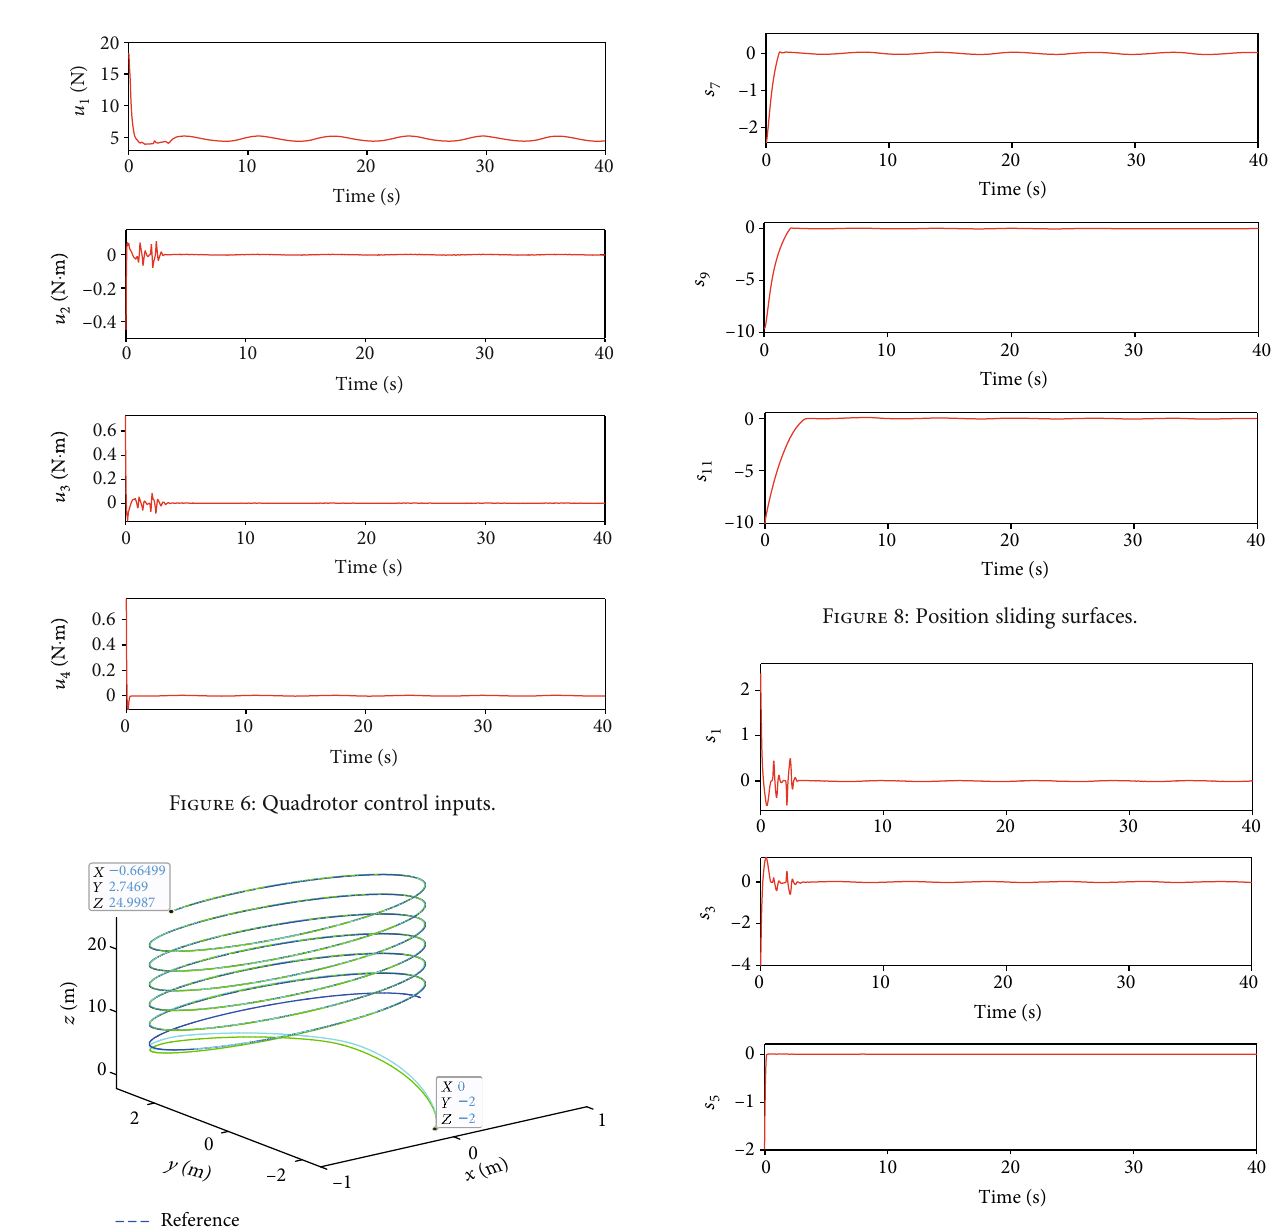
Figure 9: Attitude sliding surfaces.